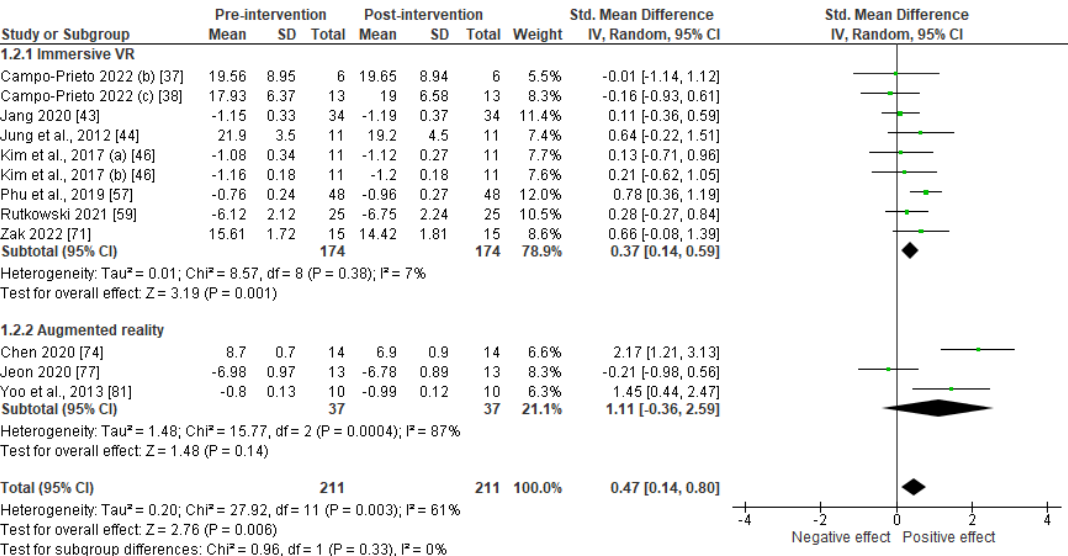
Figure 2. Forest plot of effects of intervention using immersive technologies on balance.